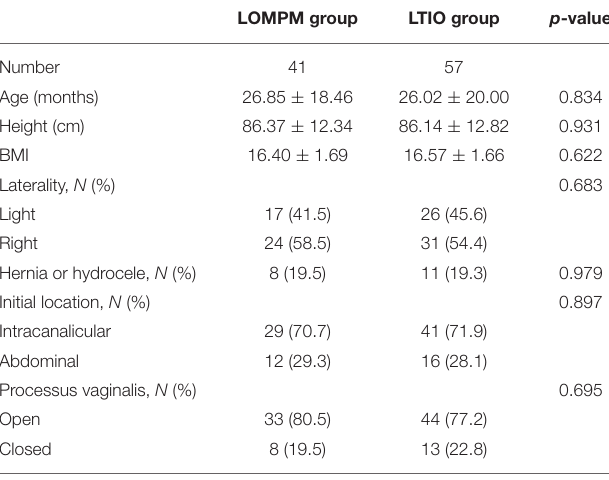
TABLE 2 | Comparison of operation time, postoperative data between the two groups.